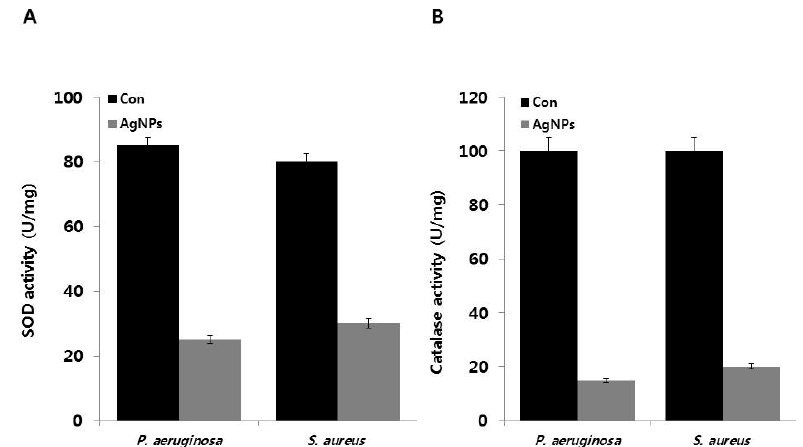
Figure 7. Effect of AgNPs on SOD and CAT activity: ( A ) P. aeruginosa and S. aureus cells were treated with respective MIC of AgNPs for 12 h. SOD ( A ); and CAT activities ( B ) were measured as described in the Materials and Methods Section. Results are expressed as the means ± SD of three separate experiments, with three replicates per experiment. Statistically significant differences between treatment and control groups were determined using student’s t -test ( p < 0.05).